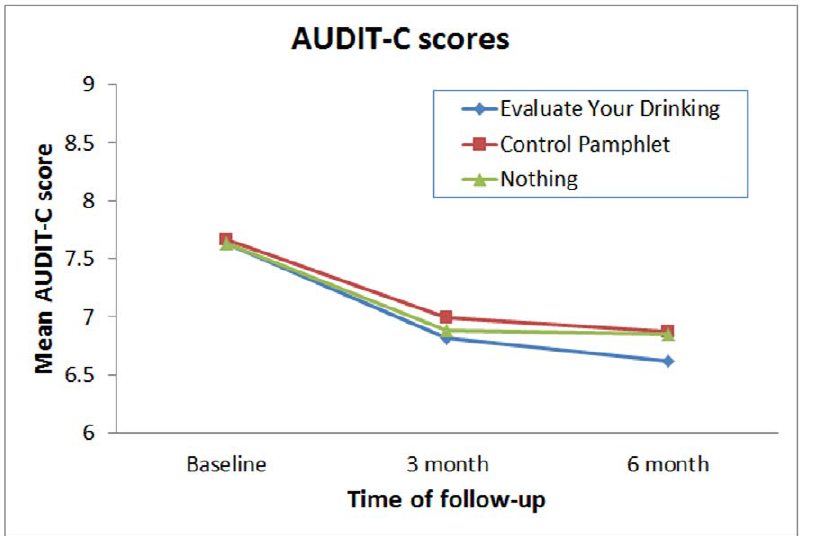
Figure 2. Mean AUDIT-C scores for participants in the three conditions across baseline, three-month, and six-month follow-ups.